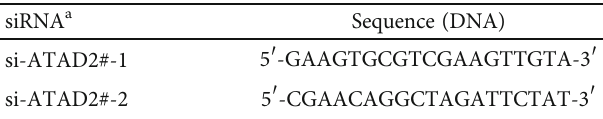
Table 2: Sequences of siRNAs targeting ATAD2 and siRNA-NC. siRNA a Sequence